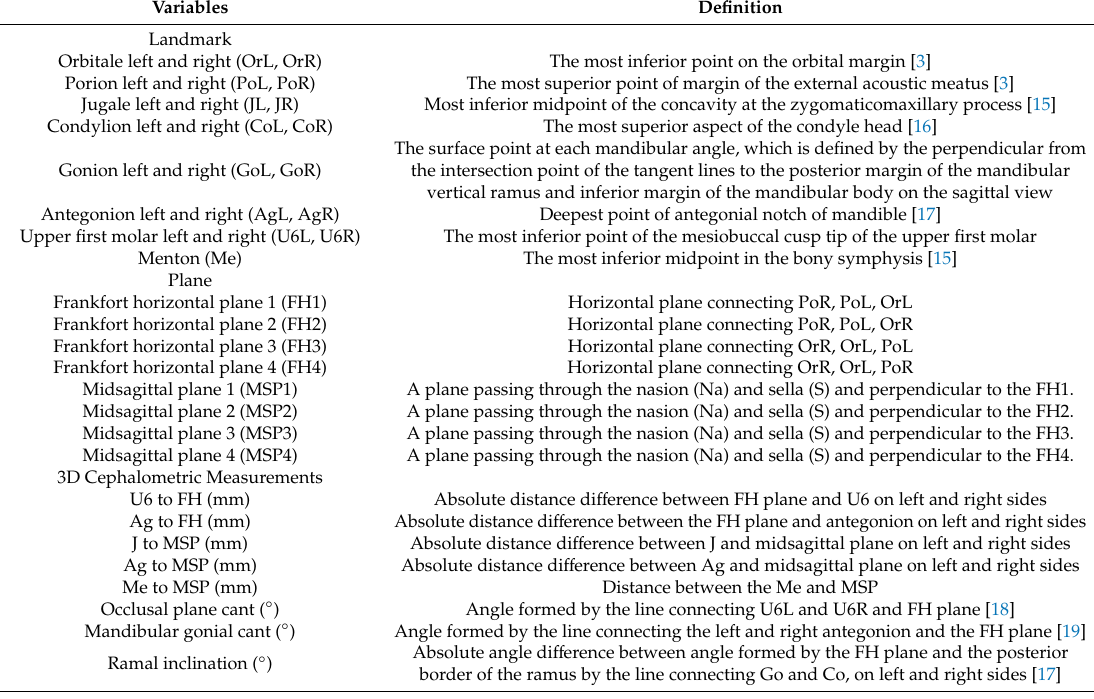
Table 2. Definition of the landmarks and 3D cephalometric reference planes and measurements for the evaluation of